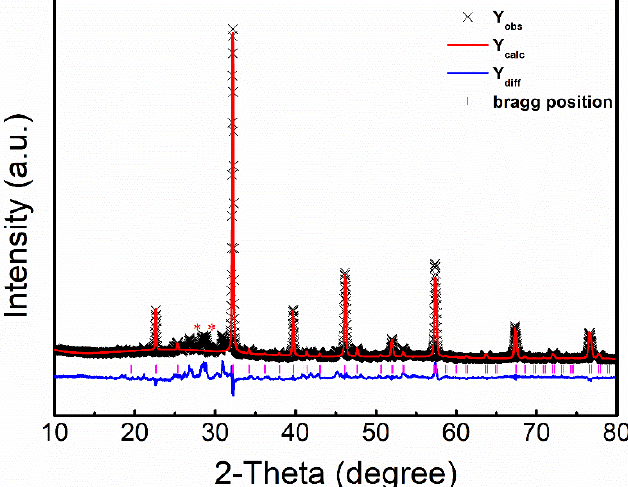
Figure 2. Comparison between the experimental XRD pattern of the LFRO powders and the calculated one, and their difference. The experimental and calculated data, and the difference are represented by black crosses, continuous red lines, and blue lines, respectively.